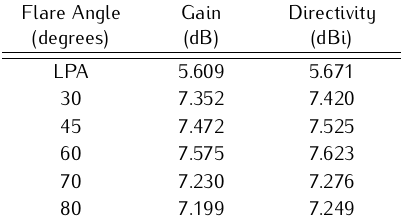
Table 1. Simulated gain and directivity at 1.37